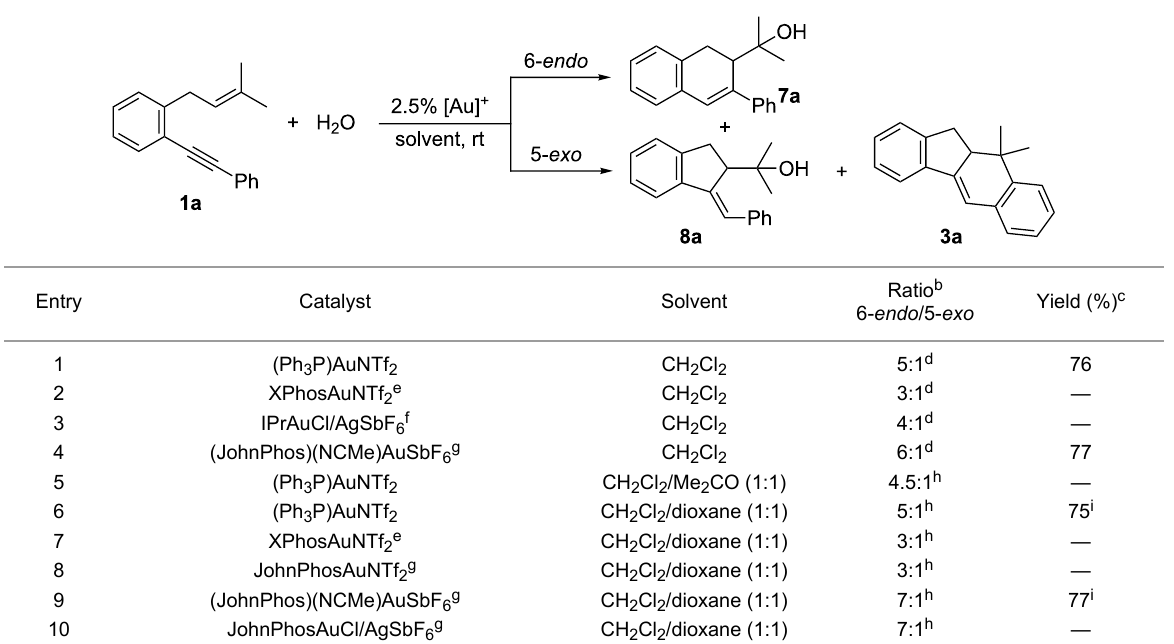
Table 1: Effect of the catalyst and reaction conditions on the hydroxycyclization of 1a . 6- Endo vs 5- exo cyclization.